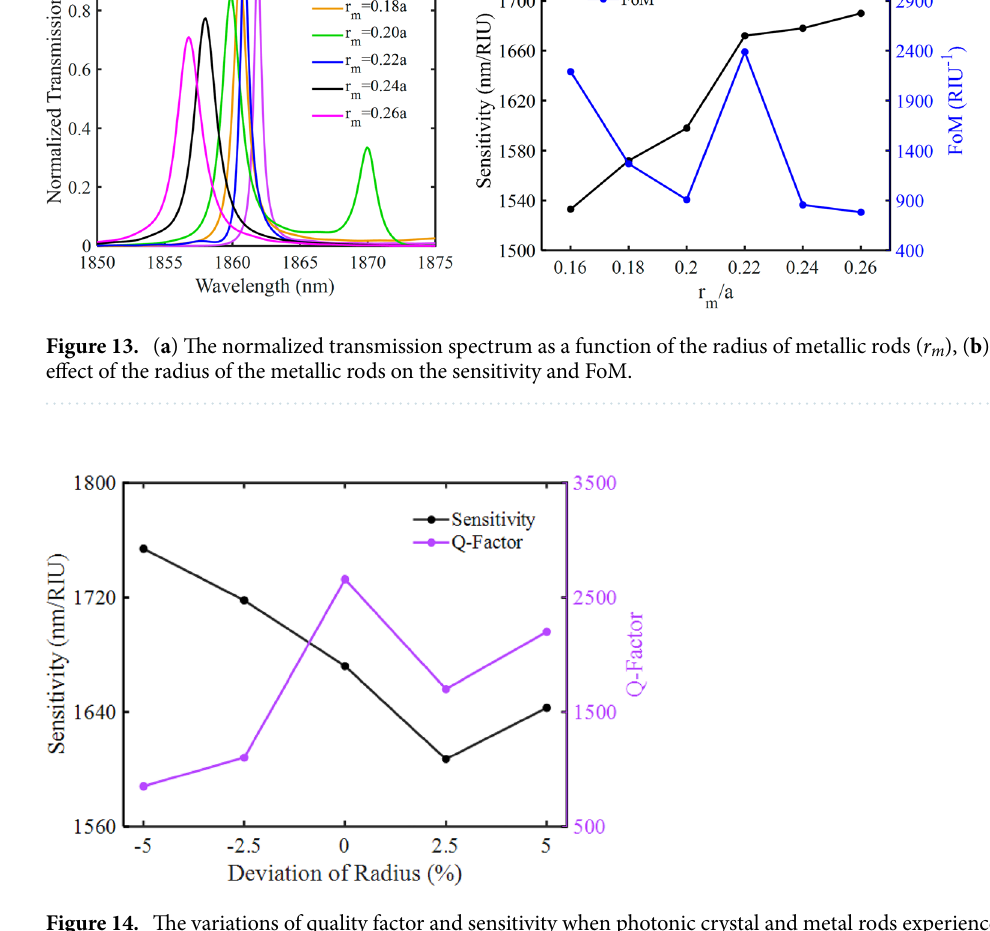
Figure 14. The variations of quality factor and sensitivity when photonic crystal and metal rods experience a radius